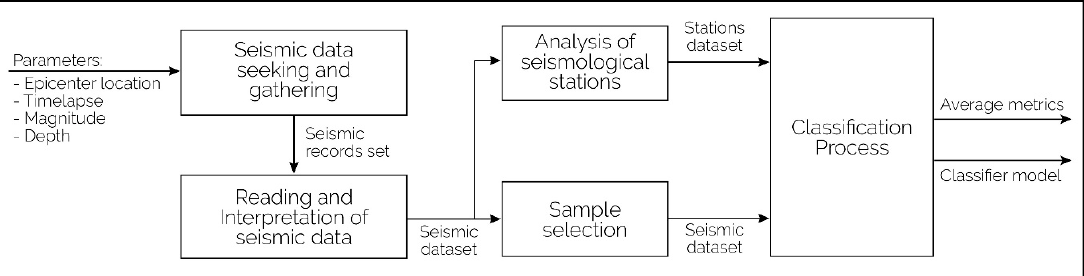
Figure 2. Model for offline seismic event detection.